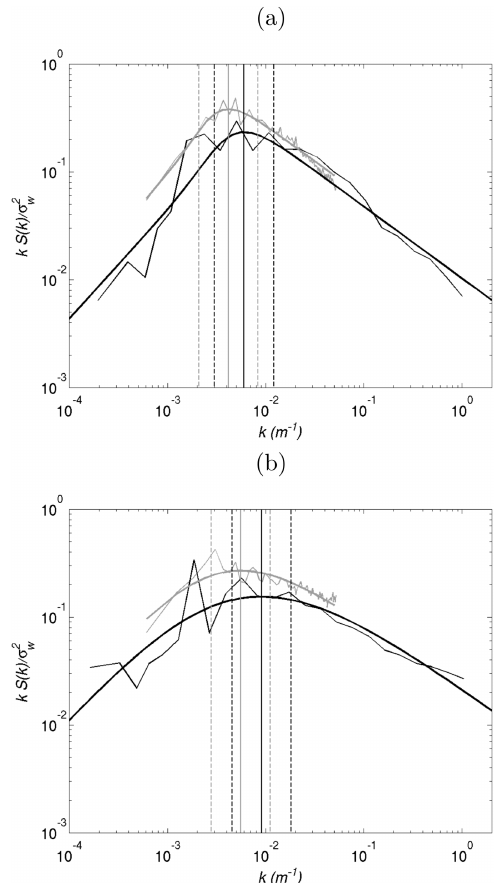
Figure 8. Normalized w spectra at (a) 15:00 and (b) 18:00UTC from both aircraft (black) and LES (grey), fitted with the KL89 an- alytical spectral model (thick lines). The vertical continuous lines represent (cid:51) w , the maximum energy wave number, and the dashed vertical lines represent k 1 and k 2 , the limits of the low wave num- ber range and of the inertial subrange, defined as k 1 = π/(cid:51) w and k 2 = 4 π/(cid:51) w